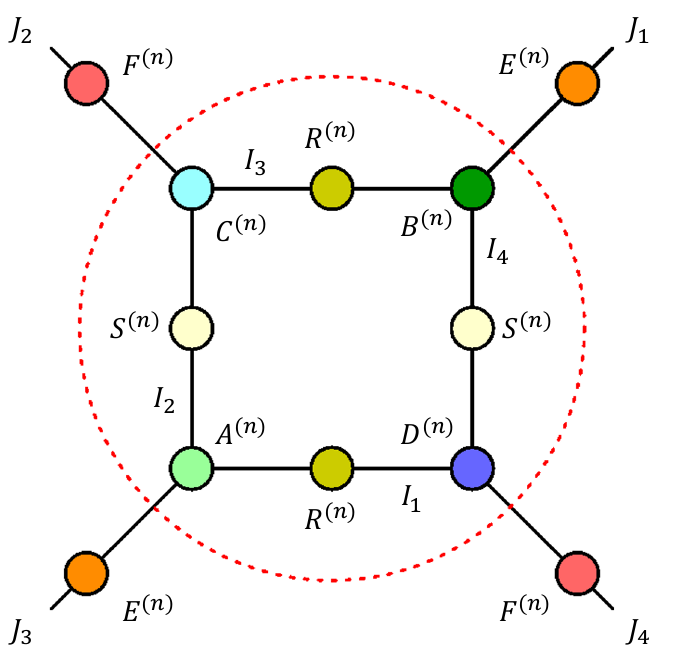
Figure 3 . Renormalization step considered in the Grassmann BTRG. The tensor contraction in the red dotted circle shows eq. (2.15). Each symbol has already been introduced in figures 1 and